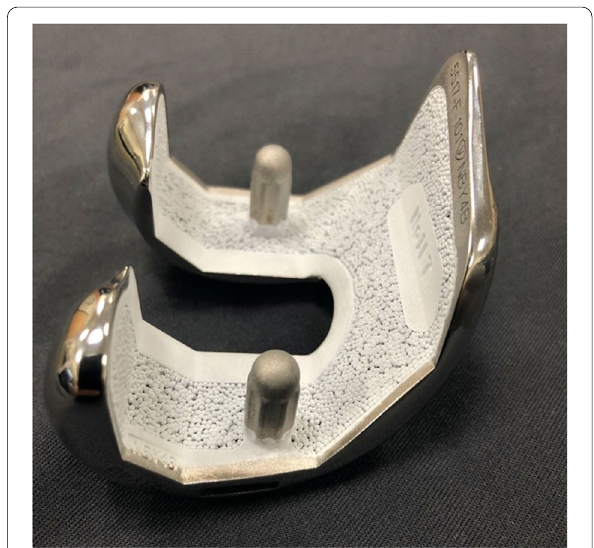
Fig. 1 Triathalon cementless femoral